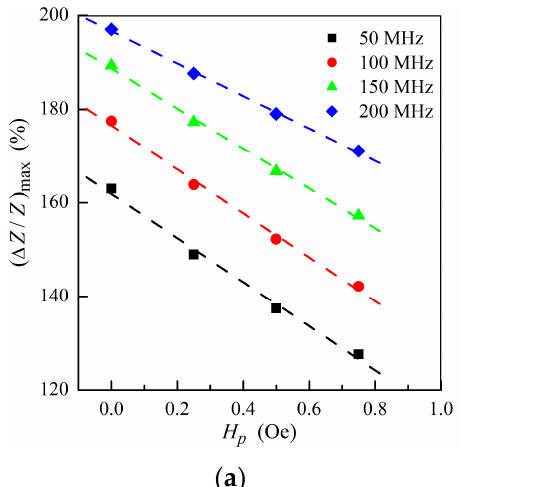
Figure 6. Frequency dependence of the concentration sensitivity S c : curve 1, symmetric multilayered film ( m = n = 4); curve 2, non-symmetric multilayer with ferrogel placed onto the surface of thin